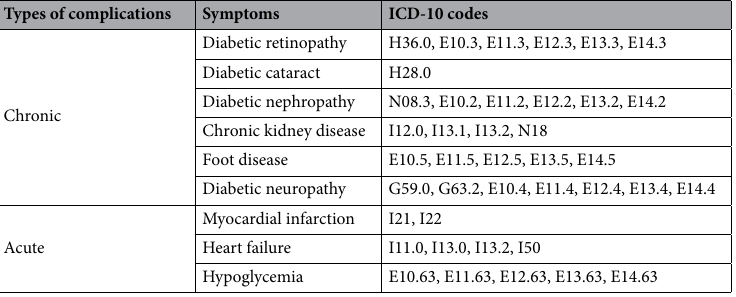
Table 1. Types, symptoms, and ICD-10 codes of complications.